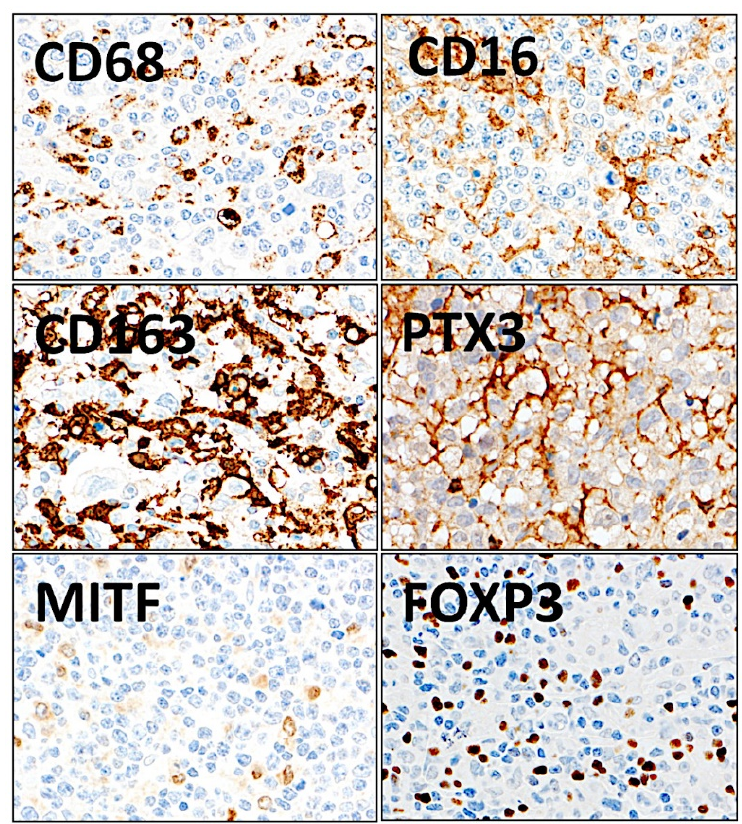
Figure 21. Immunohistochemical staining of macrophage markers and regulatory T lymphocytes (Tregs) in diffuse large B-cell lymphoma. The expression of macrophage markers and Tregs was evaluated using immunohistochemical procedures. The staining confirmed that when macrophages are present at a high concentration in the tissues, their shape is more elongated and dendriform-like. CD68 is a pan-macrophage marker, CD16 is macrophage polarization M1-like, and CD163, PTX3, and MITF are M2-like. FOXP3 is a specific marker of Tregs. Original magnification: 400×. The histological analysis in reactive tonsil, a secondary lymphoid organ, showed a dif- ferent distribution of the different markers. CD68-positive and MITF-positive macrophages were widely distributed in all areas. CD16-positive cells were scarce and only identified